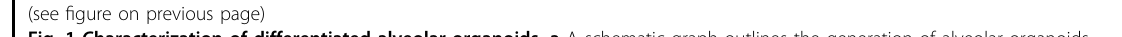
Fig. 1 Characterization of differentiated alveolar organoids. a A schematic graph outlines the generation of alveolar organoids. Photomicrographs display live lung organoids (LO) and differentiated alveolar organoids (AlvO); scale bar, 100 µm. Confocal images present LO and AlvO labeled with DAPI (blue) and Phalloidin (white); scale bar, 20 µm. See also Supplementary Figs. S1 and S2. b Parental LOs and the differentiated AlvOs were assessed for the expression level of AT1- and AT2-cell marker genes. Data represent means ± SD of a representative experiment in one organoid line, n = 2. Two-tailed unpaired Student ’ s t -test. See also Supplementary Figs. S3 – S6. c AlvOs were subjected to immuno fl uorescence staining to label AQP5 + AT1 cells (red), SFTPB + (green, top), or HTII-280 + (green, bottom) AT2 cells. Nuclei and actin fi laments were counterstained with DAPI (blue) and Phalloidin-647 (white), respectively. Scale bar, 20 µm. d Parental LOs and differentiated AlvOs were applied to fl ow cytometry to examine the abundance of AQP5 + AT1 and SFTPC + /LysoTracker red + /HTII-280 + AT2 cells. Representative histograms are shown on the top. Red, cells stained with speci fi c antibodies or dyes; blue, cells stained with isotype controls or mock-stained. Data underneath represent means ± SD of a representative experiment in one organoid line, n = 3 for AQP5 and SFTPC, n = 2 for LysoTracker red and HTII-280. Two-tailed unpaired Student ’ s t -test. See also Supplementary Fig. S7. e – i AlvOs were examined with transmission electron microscopy. e Cuboidal AT2 cells and thin AT1 cells in an alveolar organoid. Scale bar, 10 µm. f Microvilli on an AT2 cell. Scale bar, 2 µm. g Lamellar bodies in an AT2 cell. Scale bar, 1 µm. h A lamellar body within an AT2 cell. Scale bar, 200 nm. i An AT1 cell with thin cytoplasm. Scale bar, 10 µm. j AlvOs preincubated with BODIPY phosphatidylcholine (green) were further labeled with LysoTracker red (red) and then subjected to live-cell confocal imaging. Organoids were counterstained with Hoechst (blue) and CellMask ™ plasma membrane stain (white). Scale bar, 20